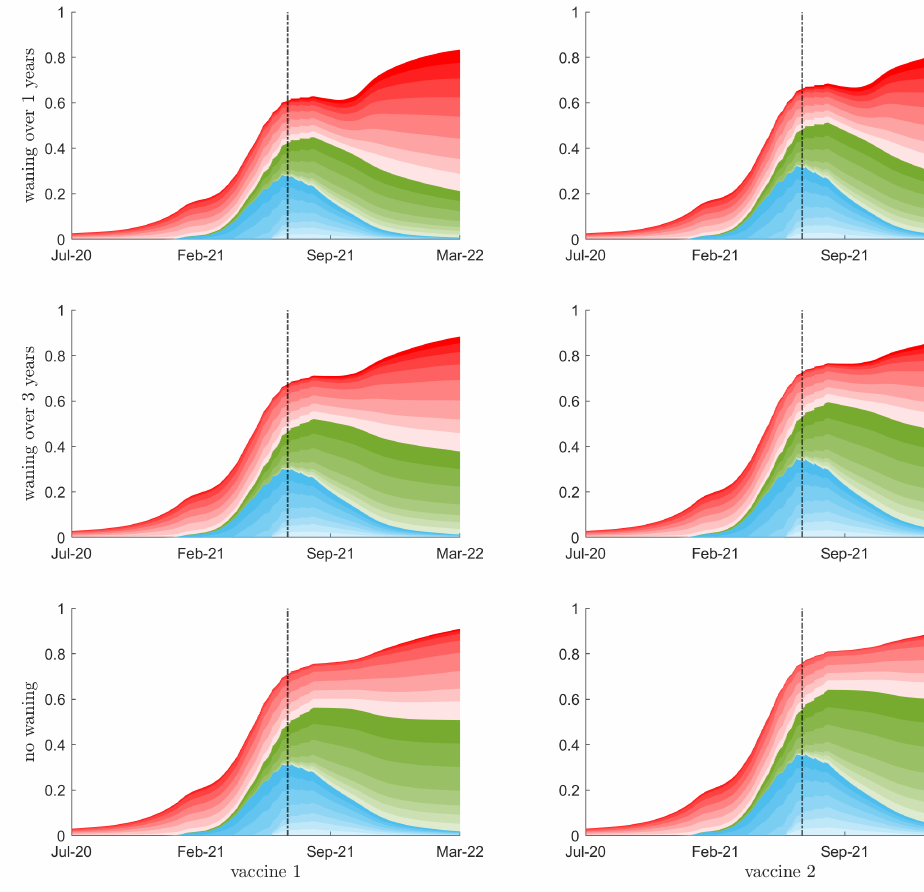
Figure 3. Seroprevalence, with a 20% relaxation of κ starting in September 2021. Showing seroprevalence as a percent of the total population for 10 year age classes, with colour intensity corresponding to age class. The red region is the sum of a susceptible classes that have been exposed to the virus, either from natural infection or through waning from the vaccinated classes. The blue and green regions show the populations of the first and second dose vaccinated classes respectively. The total population with some immunity (the top of the red region) is equal to the vertical sum of the three Blue, Red, and Green regions. The top row is waning of immunity by one year between consecutive classes; the middle row is waning of immunity of three years; the bottom row is no waning of immunity. Columns left to right represent vaccines 1 to 3, respectively. The vertical bar denotes the beginning of the prediction